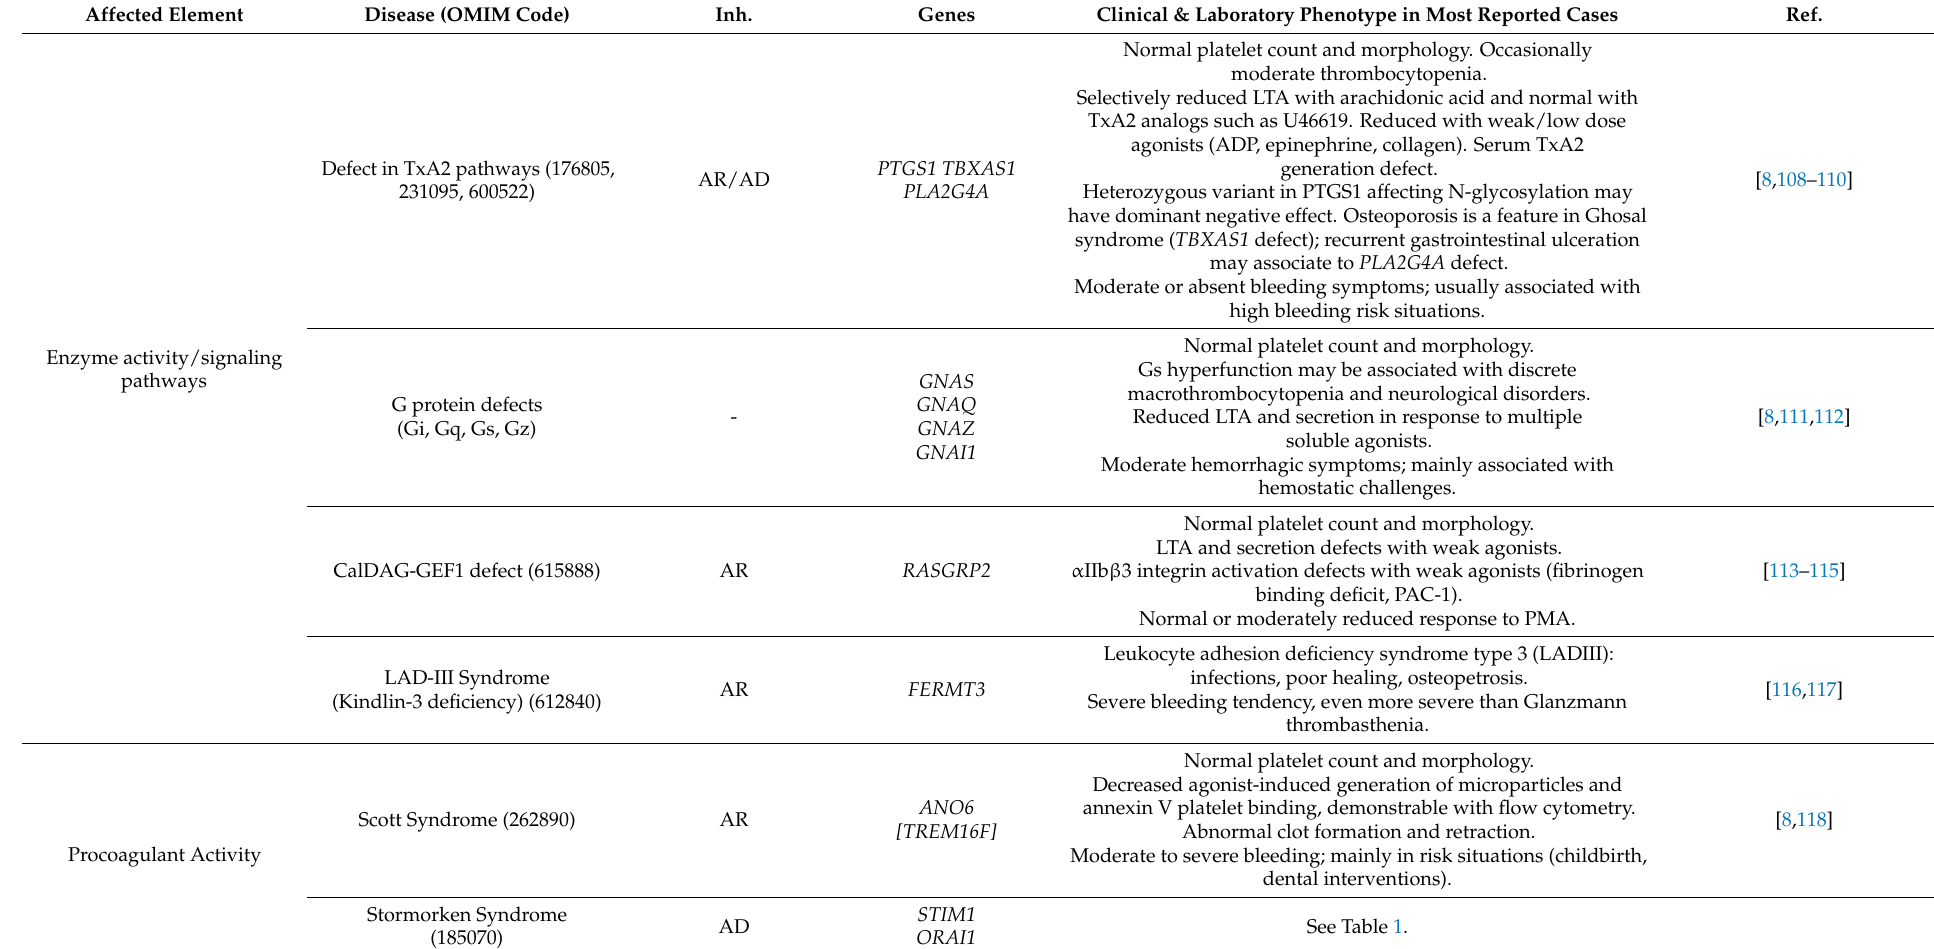
Table 4. Other inherited platelet